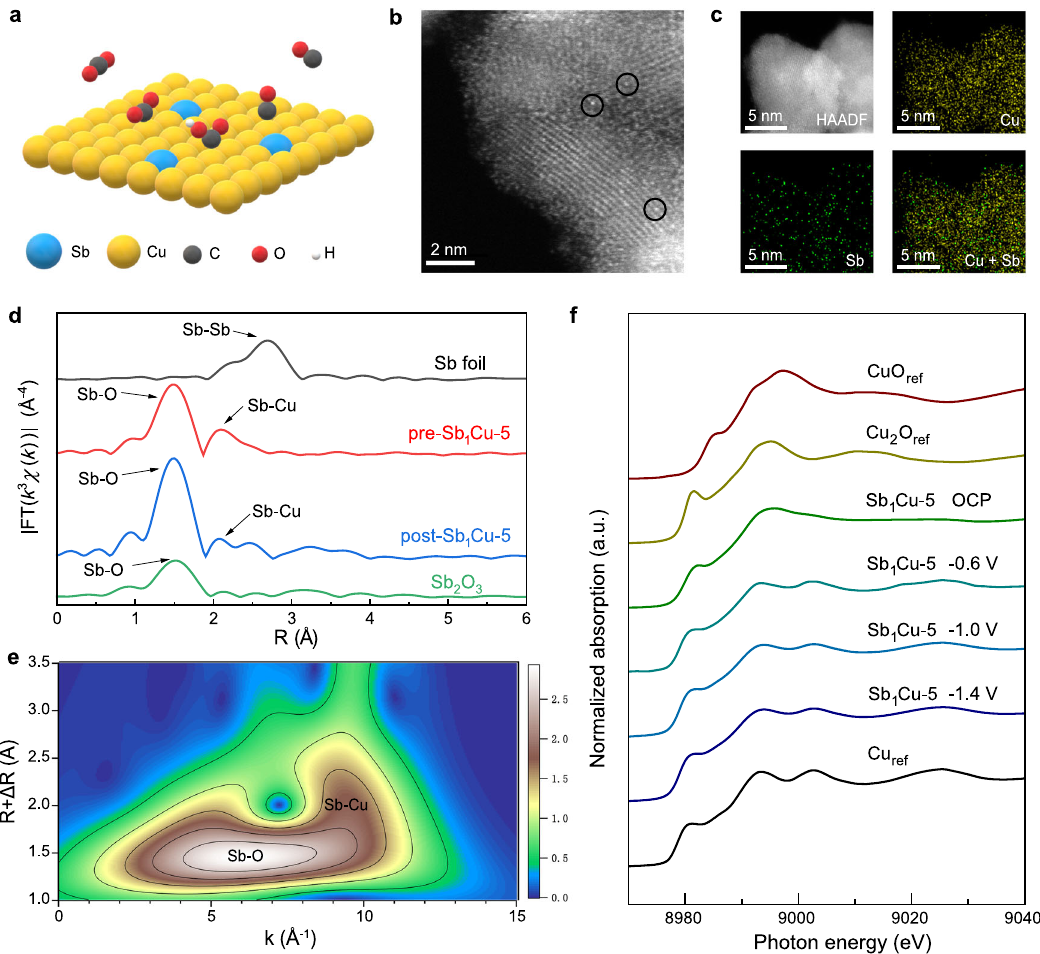
Fig. 1 | Structural characterization of the Sb 1 Cu-5 catalyst. a Schematic illus- trationof